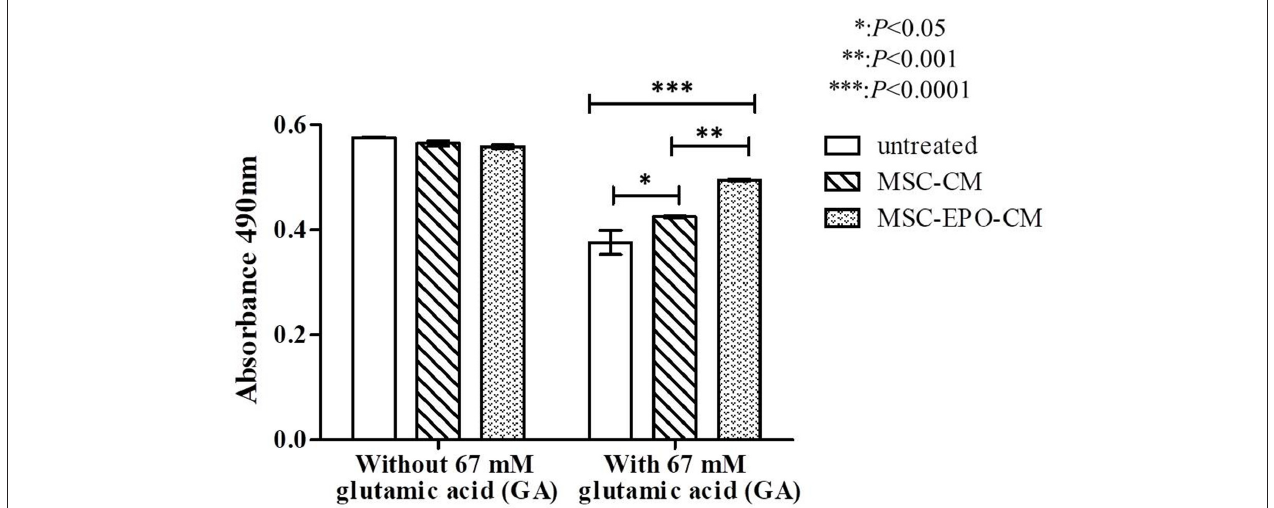
FIGURE 5 | In vitro effect of glutamate-induced toxicity on Y79 cell viability in the presence of conditioned media. Recovery of 67 mM glutamate-induced Y79 cells treated with conditioning medium derived from non-transduced (MSC-CM) and EPO -transduced (MSC-EPO-CM) MSCs was analyzed by one-way analysis of variance (ANOVA) followed by Bonferroni’s test for each mean comparison. ∗ P < 0.05 values were considered to be statistically significant. Results were expressed as mean ± standard error of the mean (SEM) of three independent experiments ( n = 8). Y79 cells exposed to the same concentration of glutamate solution in fresh MSCs culture medium was used as a